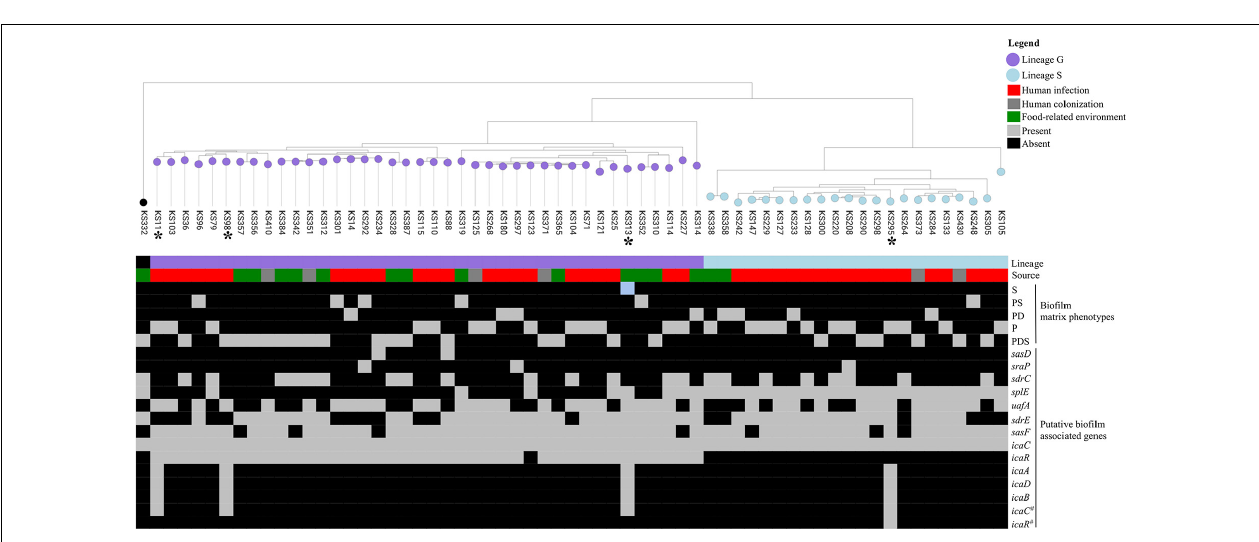
FIGURE 3 | Maximum likelihood tree of 63 Staphylococcus saprophyticus strains showing the source, genetic lineages, matrix components of biofilm, and distribution of virulence genes. Distribution of five main biofilm matrix phenotypes produced by S. saprophyticus including S, polysaccharide; PS, protein–polysaccharide; PD, protein–eDNA; P, protein; and PDS, protein–eDNA–polysaccharide is shown. Isolates marked with asterisks carried additional ica genes ( icaA , icaD , and/or icaB ). Each node represents different strains, and nodes with the same color belonged to the same lineage. The tree was constructed from the core-genome single-nucleotide polymorphism (SNP) alignment without recombination by RAxML using general time reversible model and 100 bootstrap values for node support. A comparison figure was generated using